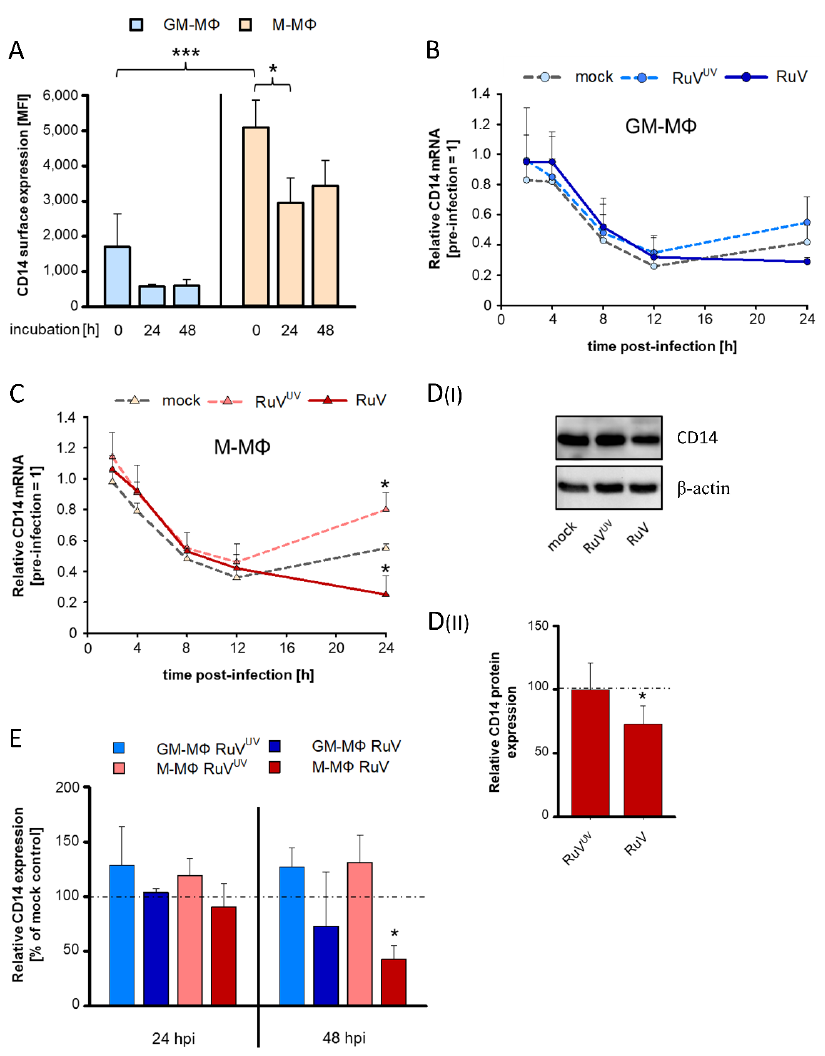
Figure 2. Downregulation of CD14 expression in GM- and M-M Φ s after RuV infection. ( A ) Surface expression of CD14 on uninfected M Φ was determined by flow cytometric analysis for indicated time points after plating of M Φ s. Data represent mean fluorescence intensity (MFI) ± SD ( n = 3). Statistical analysis was performed using ANOVA test. ( B , C ) At 2, 4, 8, 12, and 24 hpi CD14 mRNA level was quantified by qPCR relative to the before infection control (0 hpi = 1). Statistical analysis was performed using Student’s t -test and significance was calculated to the respective mock control. ( D(I) , D(II) ) RIPA lysates were generated from RuV- and RuV UV - infected MΦs at 24 hpi and analysed by Western blot with anti- E1 and β -actin antibodies. ( D(I) ) One representative blot out of three is shown. D(II) Western blot bands were quantified and E1 protein was normalized to loading control β -actin. Data represent means ± SD ( n = 3). Statistical analysis was performed using ANOVA test and significance was calculated to the mock control. ( E ) At 24 and 48 hpi CD14 surface expression on RuV- and RuV UV - infected MΦ was determined by flow cytometric analysis. Percent values of MFI ± SD are shown ( n = 3) and expressed as percent change compared to mock control (= 100%). Student’s t -test was performed for statistical analysis and significance was calculated to the mock control. * p ≤ 0.05, *** p ≤ 0.001.